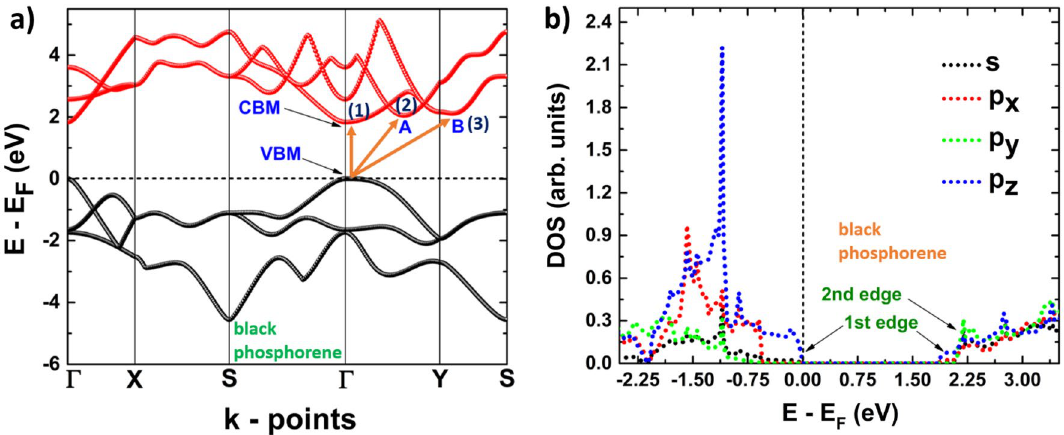
Figure 5. ( a ) Band structure; 1, 2, and 3 refer to possible electronic transitions. ( b ) projected density of states of black phosphorene.